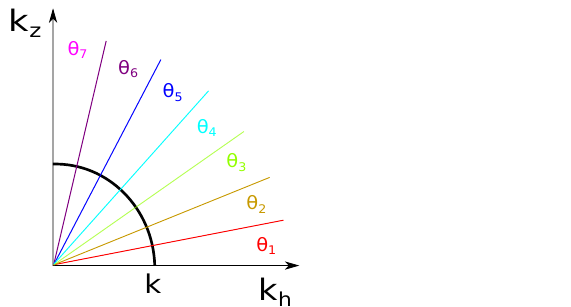
Figure 2. Decomposition of the Fourier space in elementary “cones” containing wavevectors k with given wavenumber amplitude k , and θ within discretized intervals between 0 ( k z = 0) and π /2 ( k h =